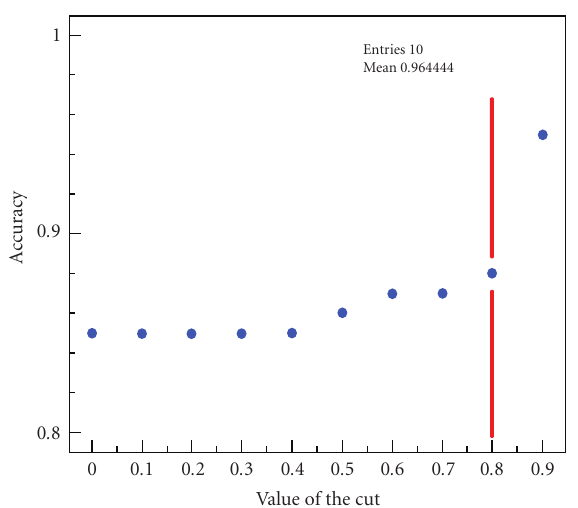
Table 3: Accuracy and mean belief using di ff erent